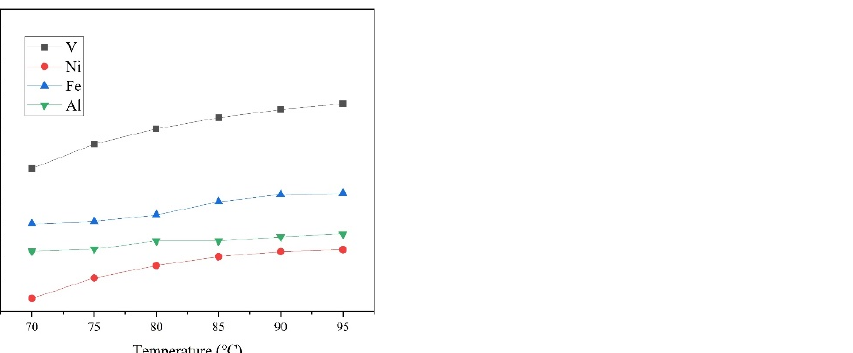
Figure 6. Effects of oxalic acid concentration on leaching efficiencies of metals (t = 240 min; T = 95 °C ; D50 ≤ 17.34 μ m)